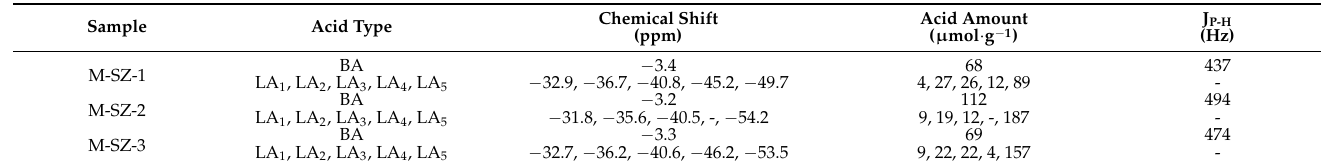
Table 2. The acidity of M-SZ-1, M-SZ-2, and M-SZ-3 acquired from 31 P MAS NMR spectra.